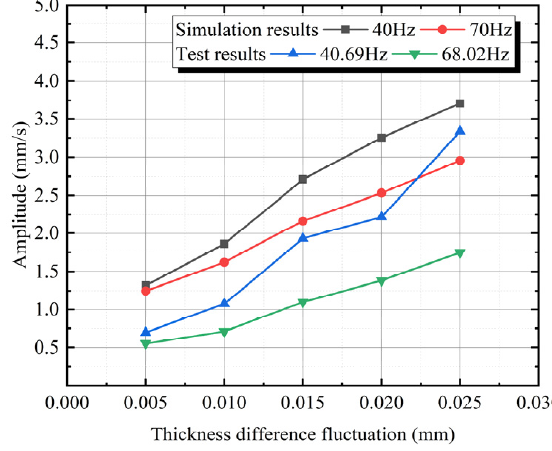
Figure 16. Plate thickness affects horizontal vibration.